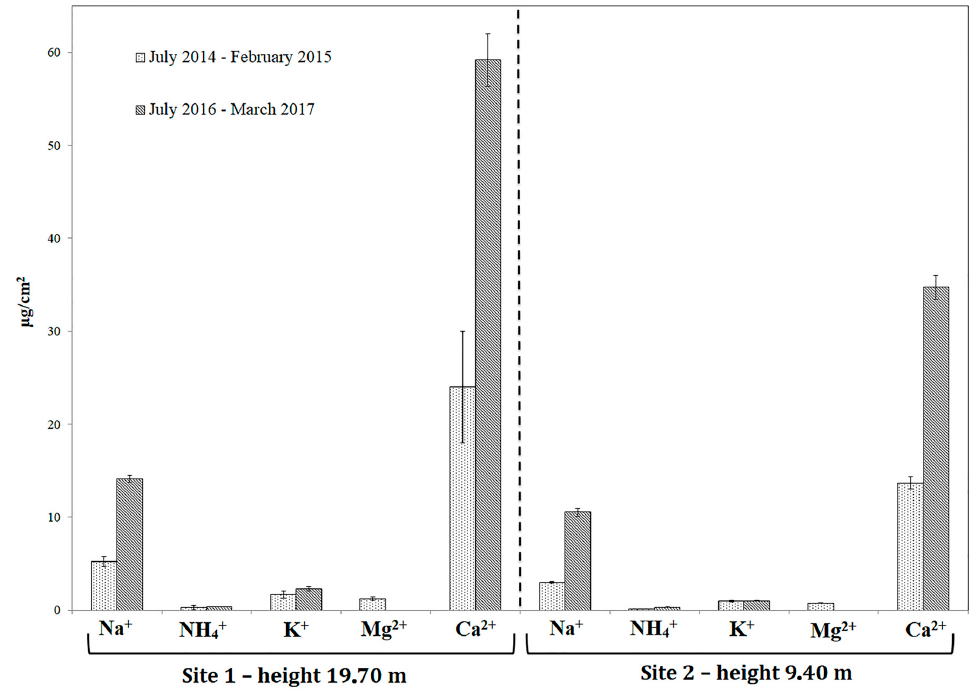
7 Figure 7. Cations average concentrations determined on the quartz fiber filters exposed in the two sites on the Duomo façade during the two